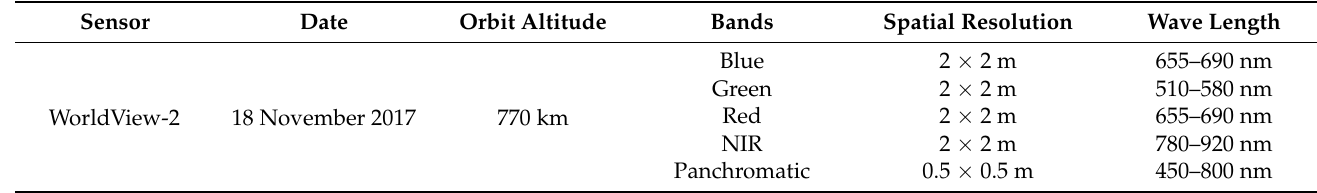
Table 1. Applied image